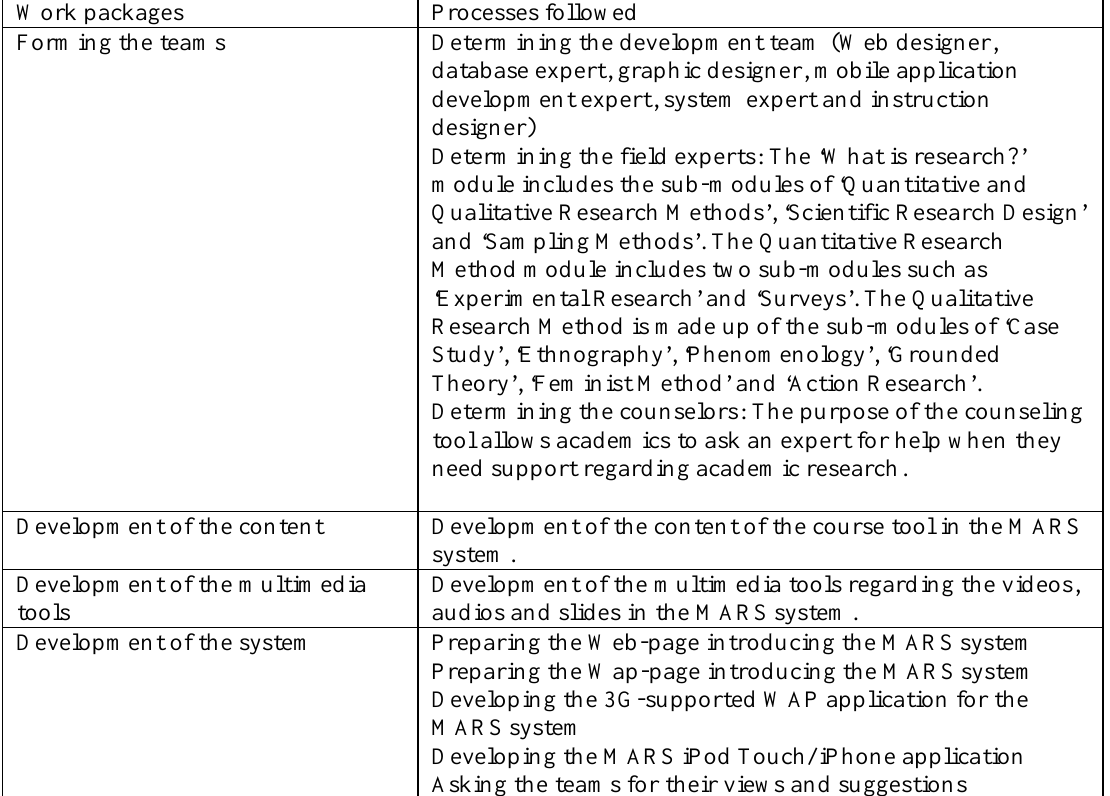
Table 4 Phases Followed for the Development of the MARS System Work